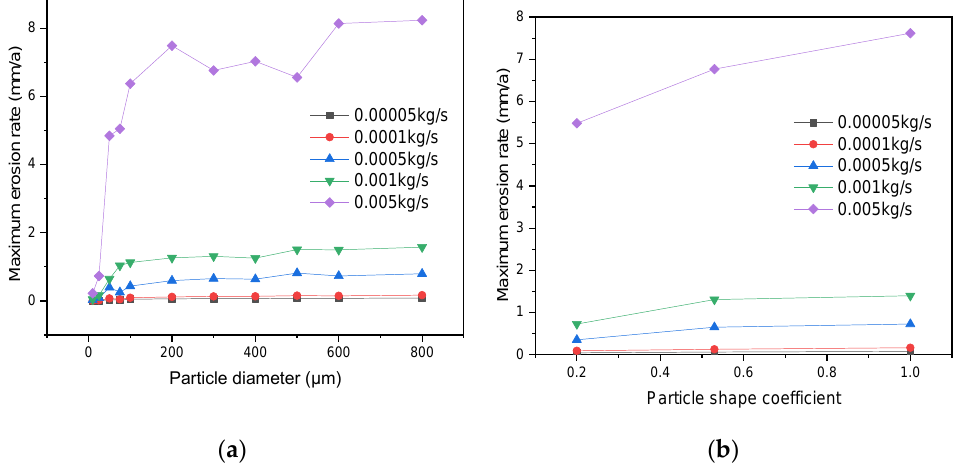
Figure 12. Effect of the particle diameter and particle shape coefficient on the maximum erosion rate. ( a ) Particle diameter; ( b ) Particle shape coefficient.